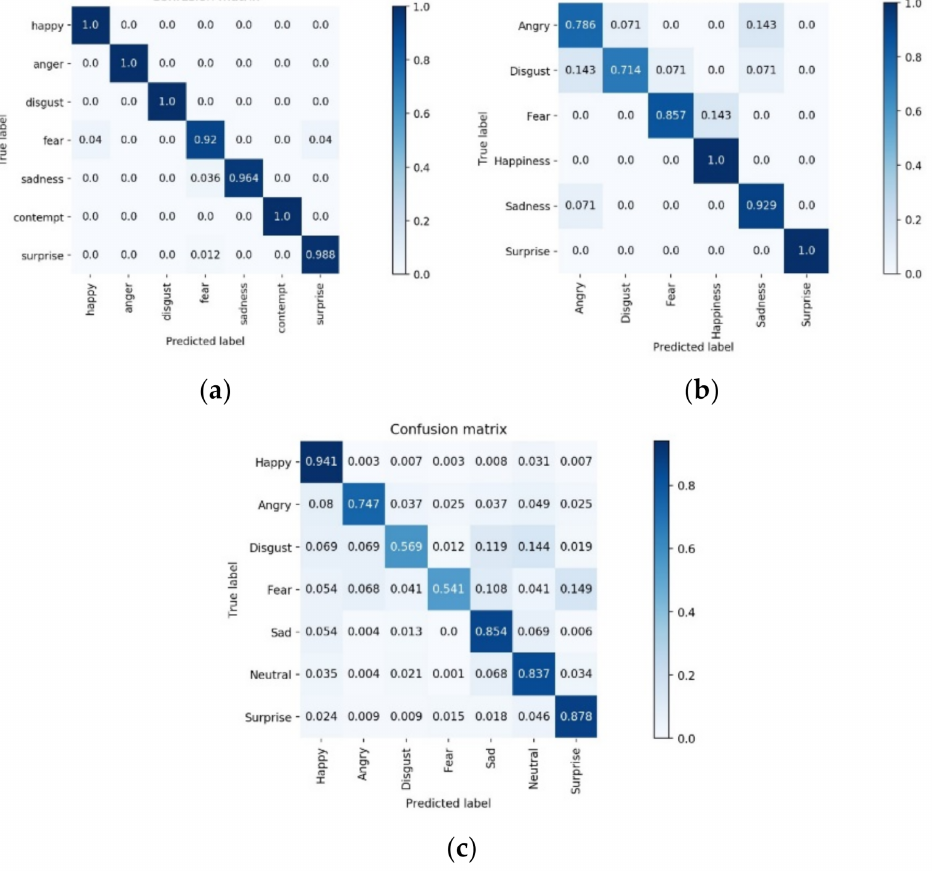
0.5 and 1. The higher the AUC value, the better the model’s